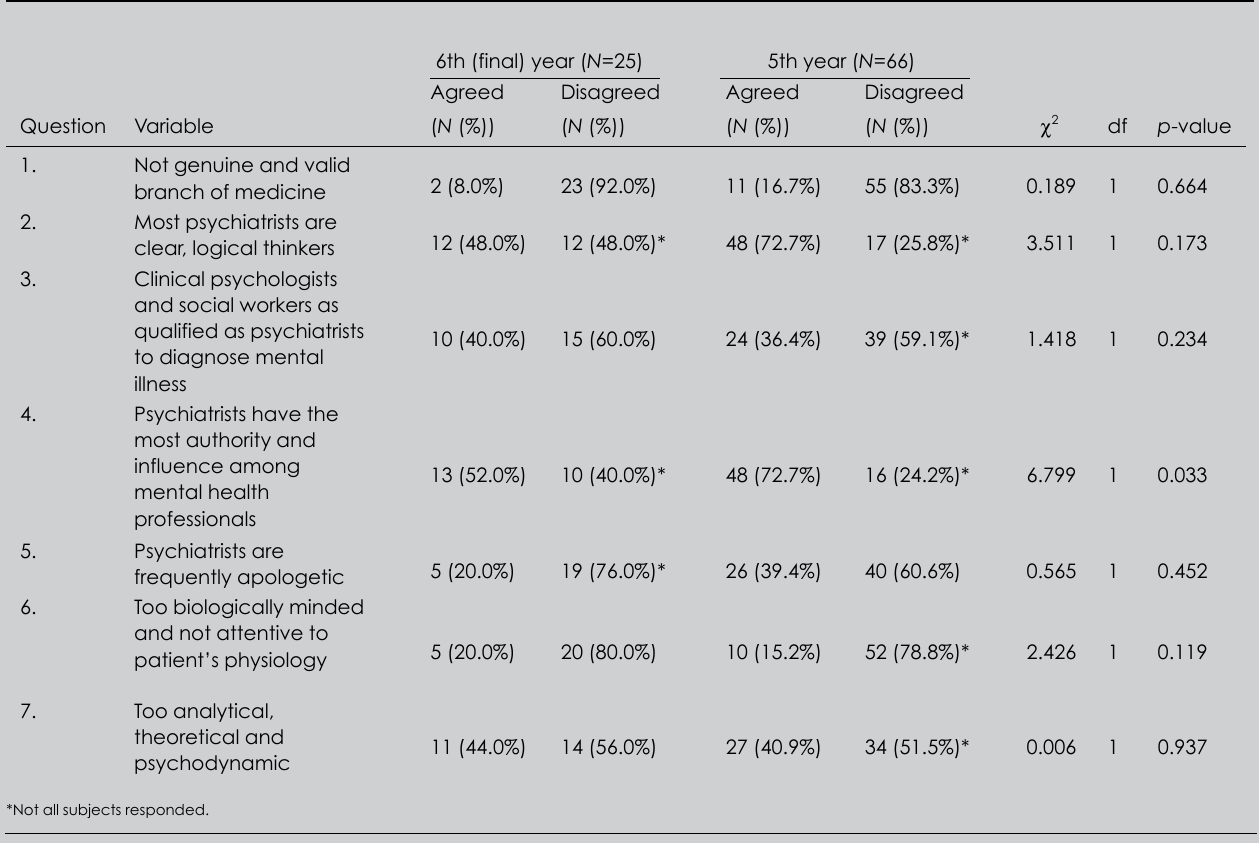
Table II. Responses on the role and functioning of psychiatrists from clinical medical students at Bayero University, Kano,